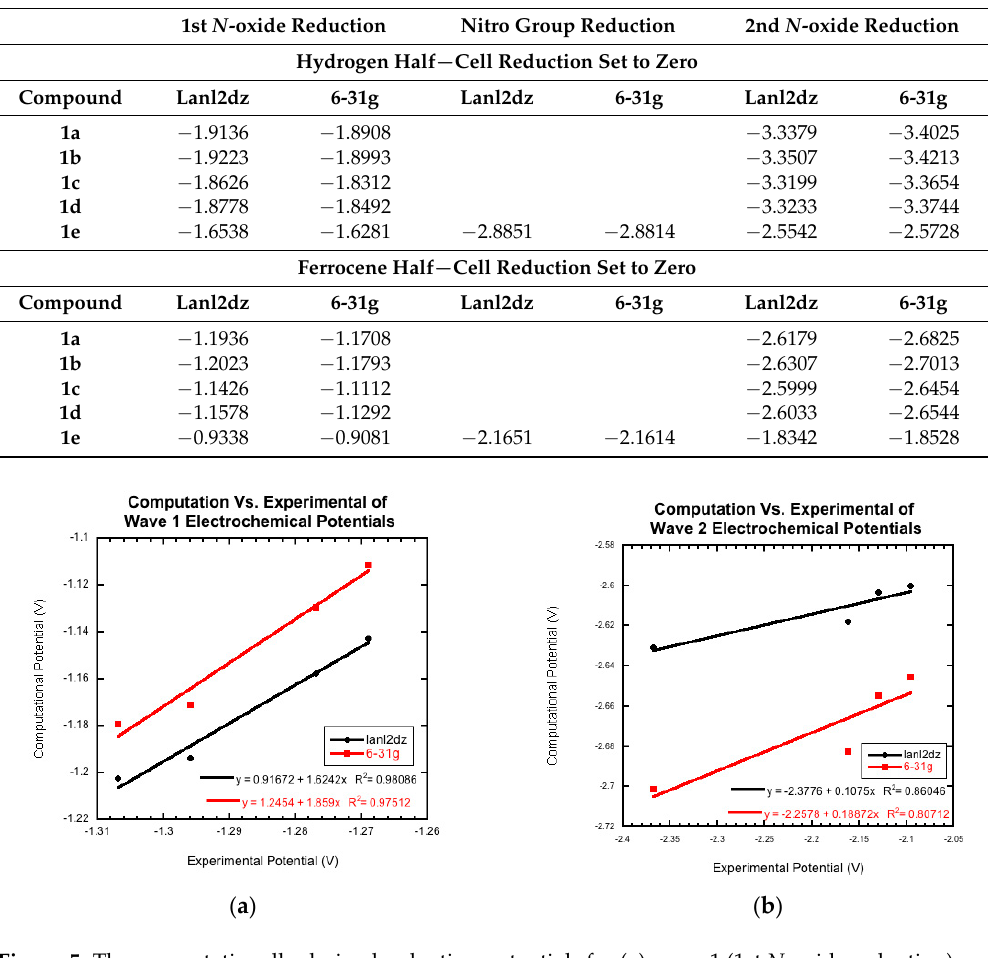
Figure 5. The computationally derived reduction potentials for ( a ) wave 1 (1st N -oxide reduction) and ( b ) wave 2 (2nd N -oxide reduction) compared to the experimentally measured data demonstrates a strong correlation. The basis set for lanl2dz, shown in black, can be compared to 6-31g, shown in red.